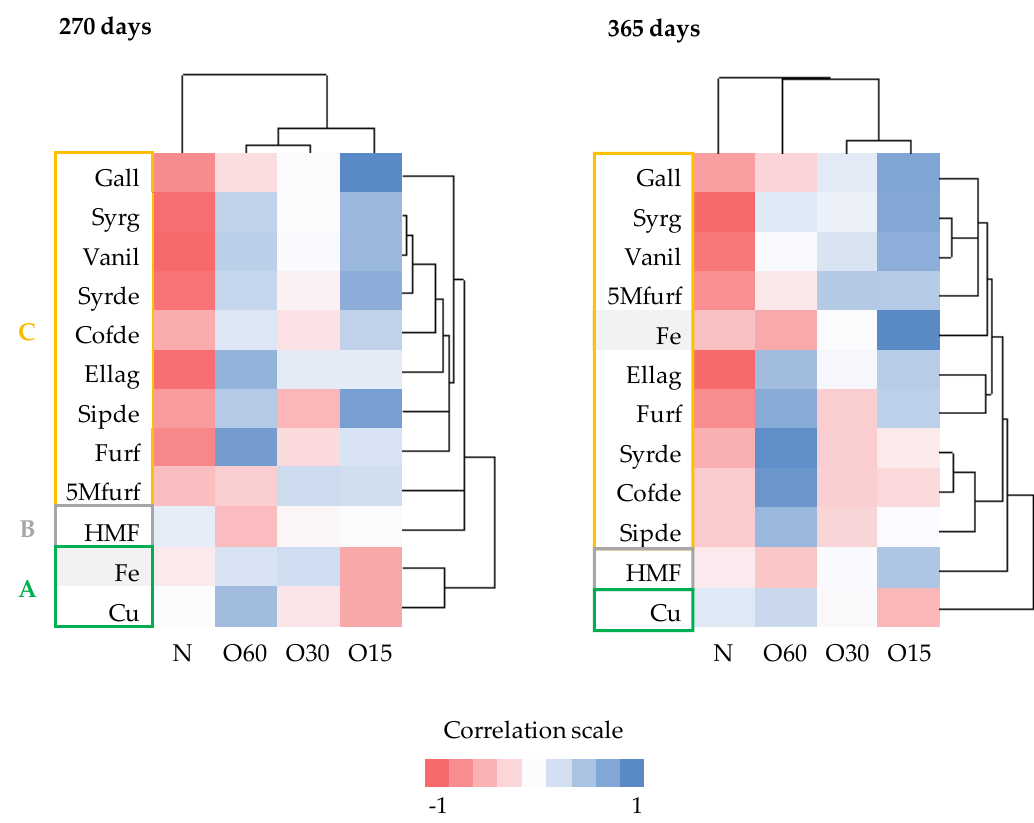
Figure 5. Heat maps plotting clusters of low molecular weight compounds, iron and copper and ageing modalities of wine spirits at 270 and 365 days of ageing.